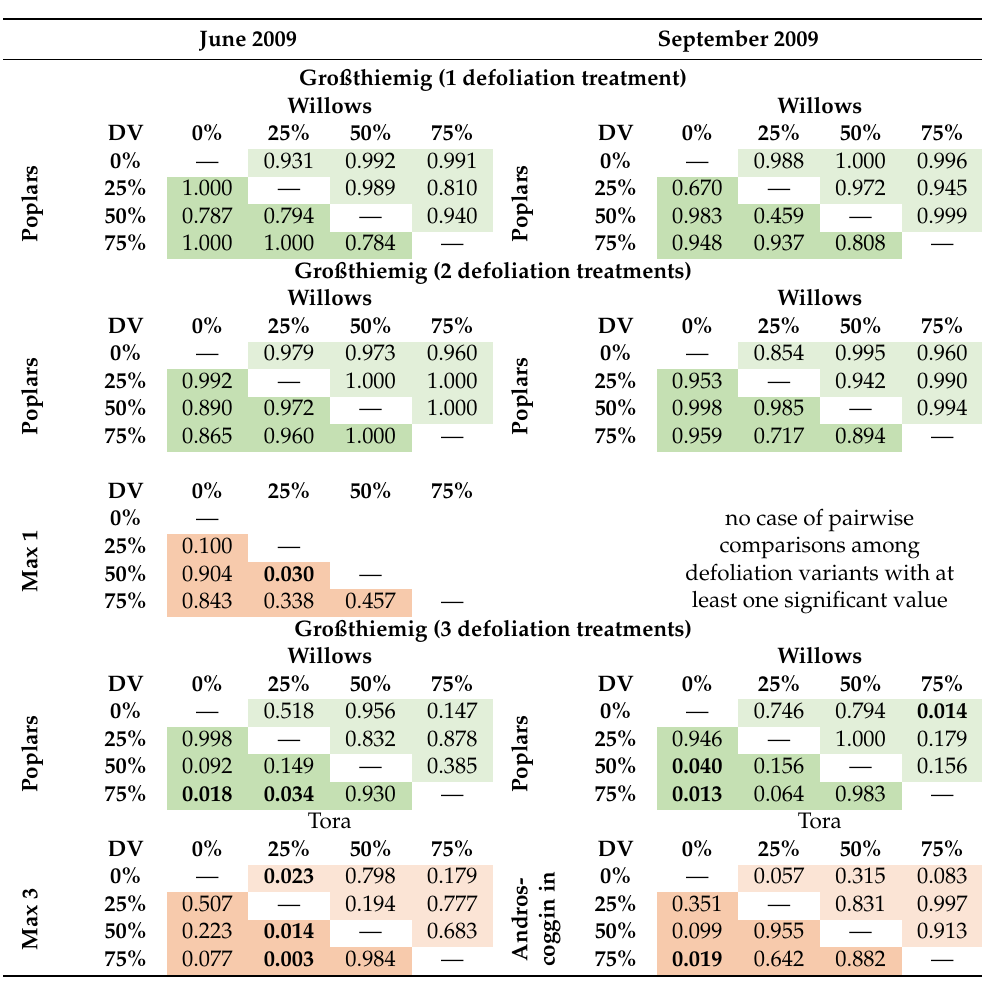
Table 7. p values of pairwise comparisons of plant heights among former defoliation variants (DVs) for both tree genera (green) as well as for all varieties with at least one significant value (orange) on the study site in Großthiemig in June and in September 2009 after a harvest in March 2009 with regard to the number of defoliation treatments in 2007 and 2008 via Tukey HSD test (bold values indicate statistically significant